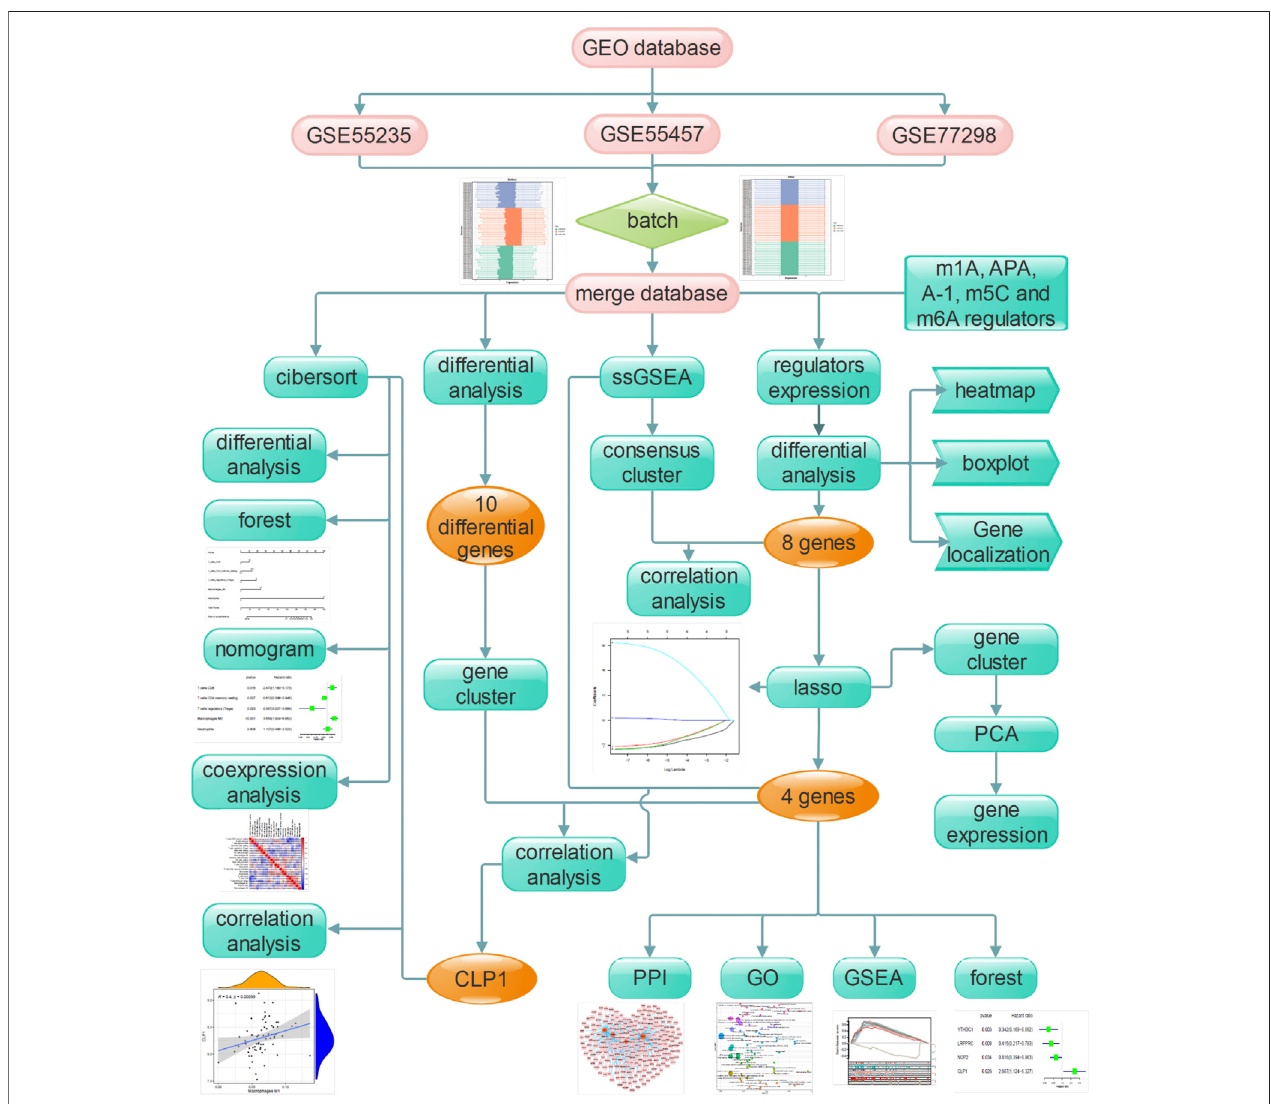
FIGURE 1 | The fl ow chart of the current study. This study compared the expression characteristics of RNA modi fi ers and immune in fi ltration characteristics in rheumatoid customs and normal synovial tissues, constructed a prediction model and a miRNA/transcription factor-RNA modi fi er interaction network, and performed molecular subtype analysis to screen out the diagnosis